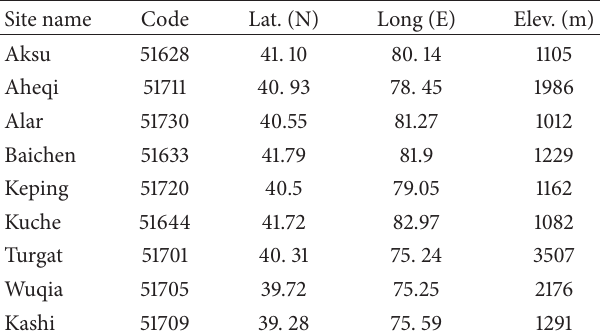
Table 1: Location of the